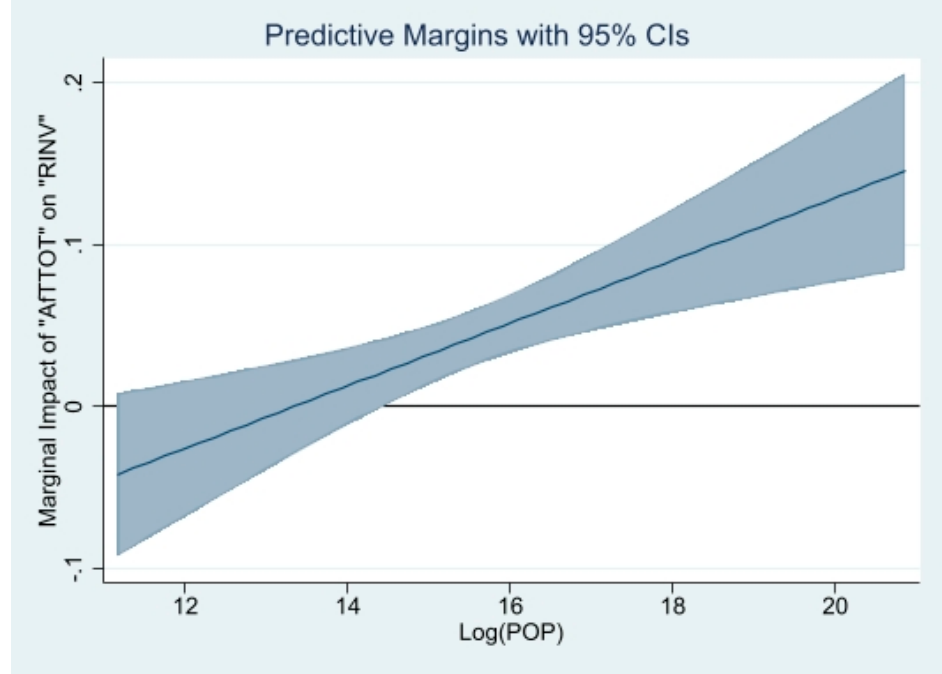
Figure 5. Marginal impact of “AfTTOT” on “RINV” for varying population sizes. Source: